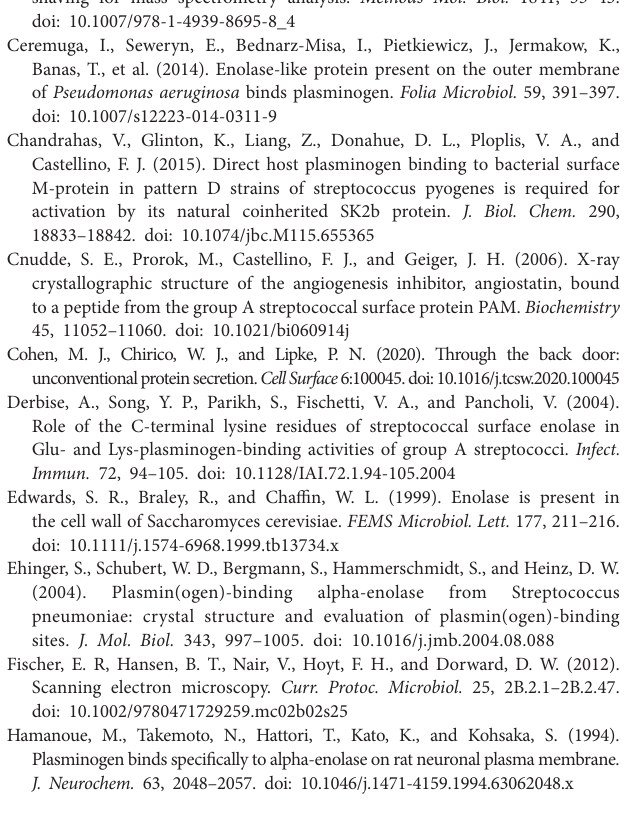
Supplementary Figure 1 | Scanning Electron Microscopy (SEM) analysis of the presence of Sen on isogenic AP53 cells. GAS-AP53 cells were grown to mid-log phase and incubated with rabbit-anti Sen or hPg followed by mouse-anti hPg to determine the relative abundance of Sen on the surface of isogenic AP53 strains. The samples were imaged using the Magellan 400 FESEM to assess the abundance of bound antibody in different isogenic strains. (A) WT-AP53 cells without antibody. (B) WT-AP53 cells with rabbit-anti Sen. (C) WT-AP53 cells with hPg followed by mouse-anti hPg. (D) AP53/ ∆ pam cells with rabbit-anti Sen. (E) AP53/ pam[8A] cells with rabbit anti-Sen. (F) AP53/ pam[8A] cells with hPg followed by mouse-anti hPg. Supplementary Figure 2 | SEM analysis of the presence of Sen on isogenic SF370 cells. GAS-SF370 cells were grown to mid-log phase and incubated with rabbit-anti Sen to determine the relative abundance of Sen on the cell surface. The samples were imaged using the Magellan 400 FESEM for determination of the abundance of bound antibody. (A) WT-SF370 cells with rabbit-anti Sen. (B) SF370/ ∆ M1 cells with rabbit-anti Sen. (C) Bar representation of median fluorescence intensity (MFI) obtained from FCA of the binding of rabbit-anti Sen to SF370 and SF370/ ∆ M1 cells as a function of the growth phase of the cells. OD 600nm of 0.3, 0.55, and 1 are early log-phase, mid log-phase, and stationery-phase of growth,